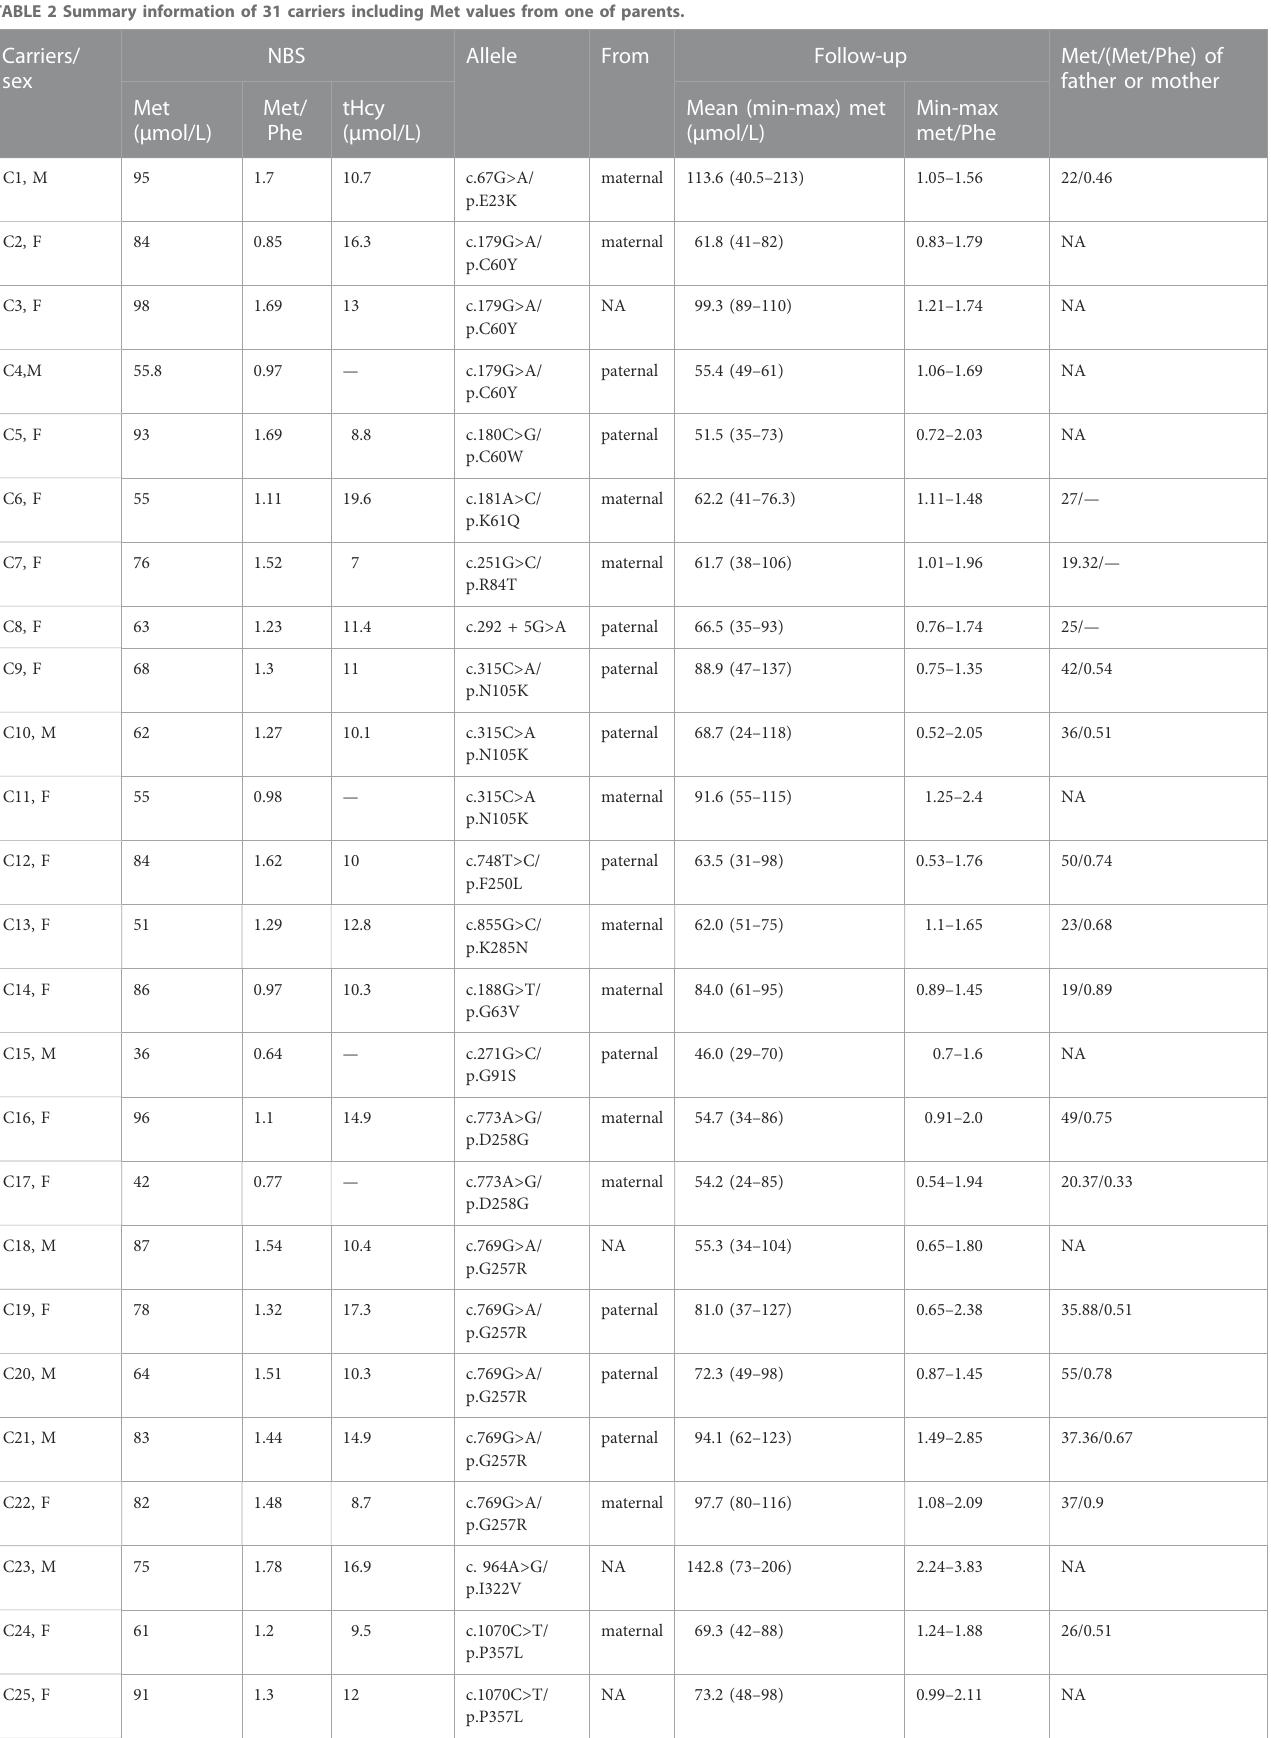
TABLE 2 Summary information of 31 carriers including Met values from one of parents. Carriers/ NBS Allele From sex